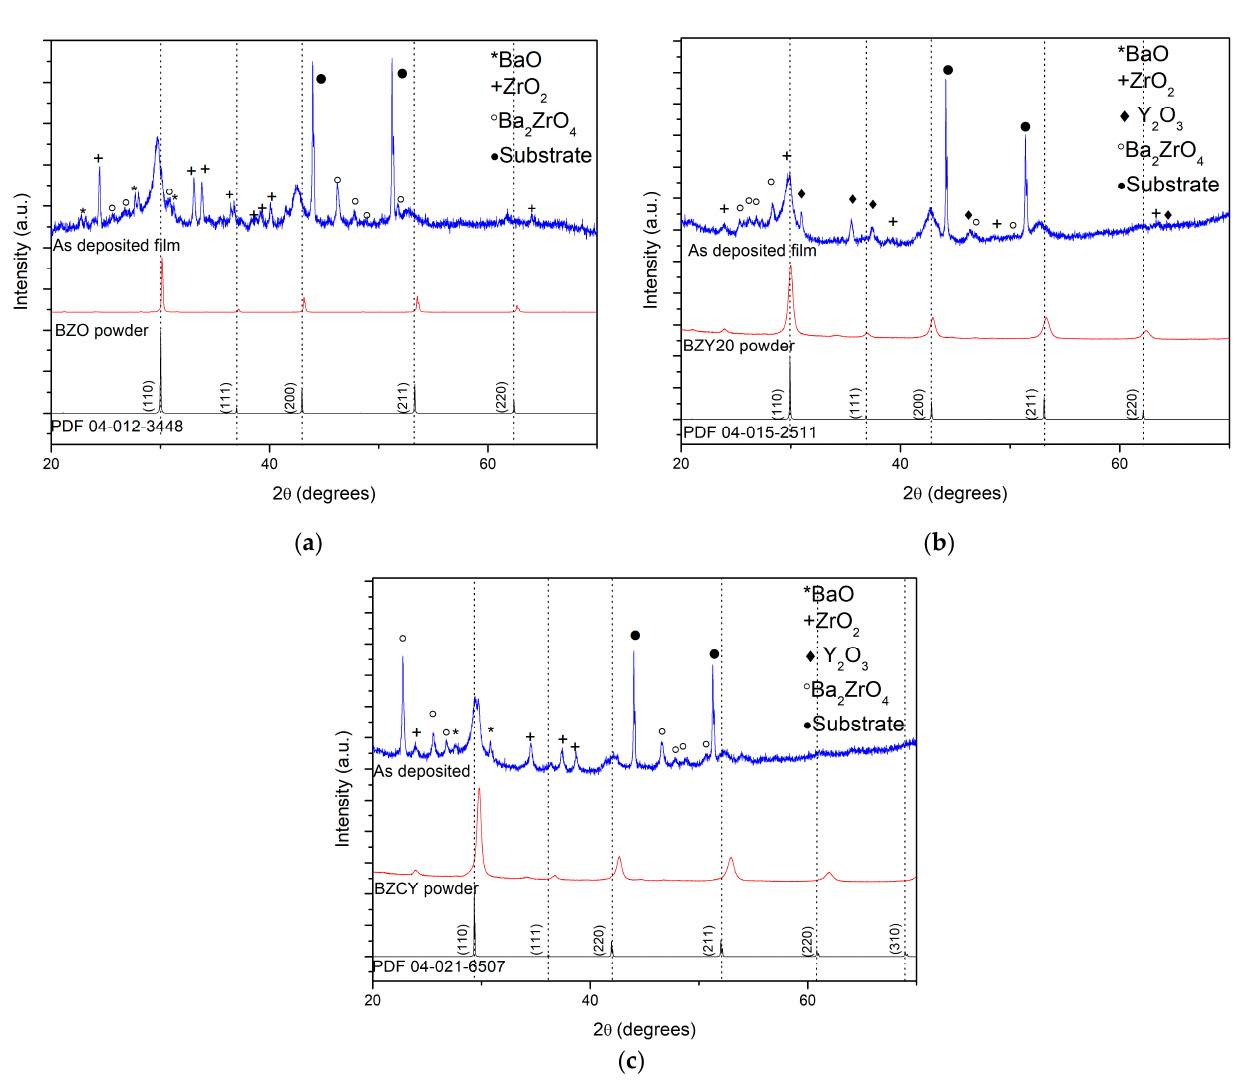
Figure 4. XRD patterns of ( a ) BZO thin films and initial powder; ( b ) BZY20 thin films and initial powders; and ( c ) BZCY thin films and initial powder. Table 3. Lattice parameters and crystallite sizes of the formed thin films in comparison to the initial powder material’s lattice parameters and crystallite